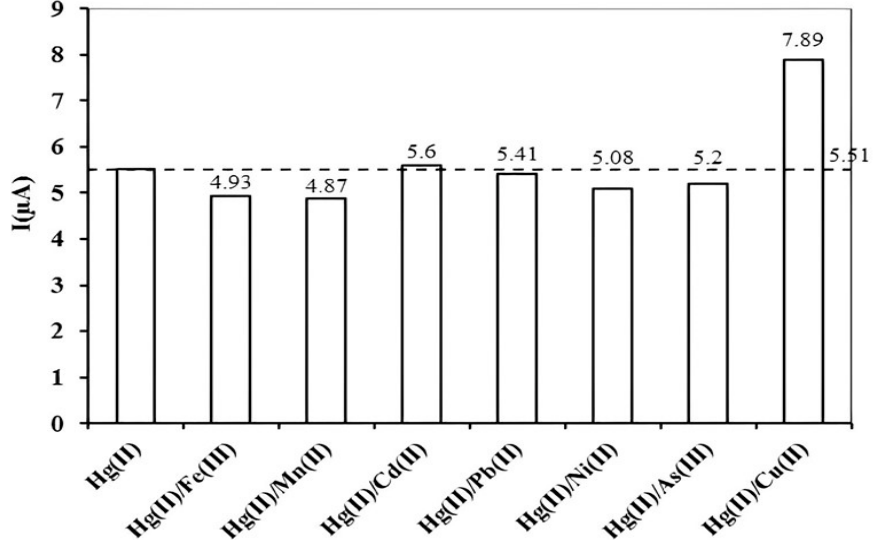
Figure 5. Interference studies of Hg (II) with binary systems of metal cations (Fe 3+ , Mn 2+ , Ni 2+ , Pb 2+ , Cd 2+ , Cu 2+ , As 3+ ) at concentration ratio of 1:20; operating conditions were: pH 7, deposition potential − 0.7 V, biomass concentration 5%, accumulation time 12 min, concentration of Hg (II) (10 µgL − 1 ), and concentration of interfering ions (200 µgL − 1 each).